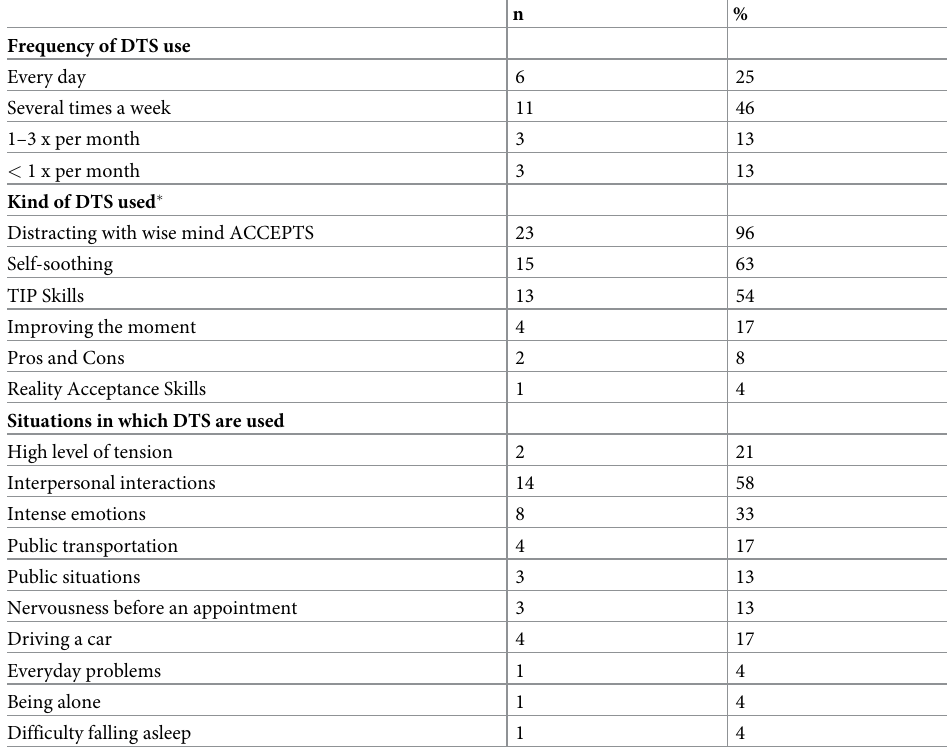
Table 3. Background information on the use of Distress Tolerance Skills (N = 24).